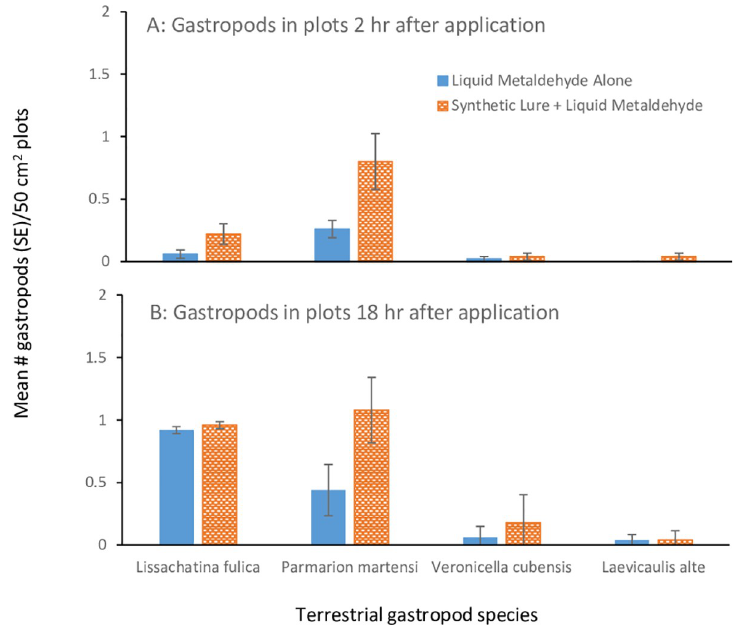
Fig 3. The mean number of giant African snails ( Lissachatina fulica ), semi-slugs ( Parmarion martensi ), Cuban slug ( Veronicella cubensis ) and black slugs ( Laevicaulis alte ) found in 50 cm 2 plots (n = 50) 2 h (a) and 12 h (b) after application of liquid metaldehyde alone or liquid metaldehyde combined with 0.2% synthetic lure